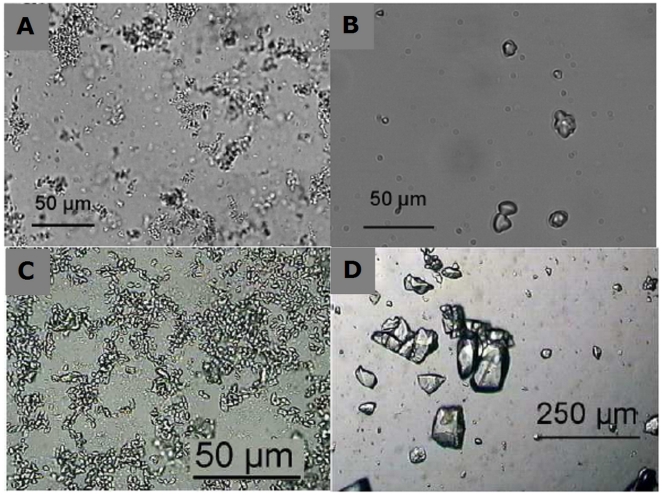
Crystallization trials of urate oxidase from pool 1 and pool 3 either via addition of poloxamer or via reverse dialysis.Crystallization trials of urate oxidase from pool 1 and 3. Top) Crystallization conditions of pool 1. A) cUOx≈35 mg/mL, 5% poloxamer 188, NH4Cl 20 mM, Tris 5 mM pH 8.5. B) cUOx≈40 mg/mL, Tris 5 mM pH 7.5, 20 mM NH4Cl vs. Tris 5 mM pH 7.5. Bottom) Crystallization of pool 3. C) cUOx≈11 mg/mL, 2.5% poloxamer 188, NH4Cl 45 mM, Tris 50 mM pH 7.5. D) cUOx≈68 mg/mL 100 mM NH4Cl, Tris 50 mM pH 7.5 vs. Tris 50 mM pH 7.5.